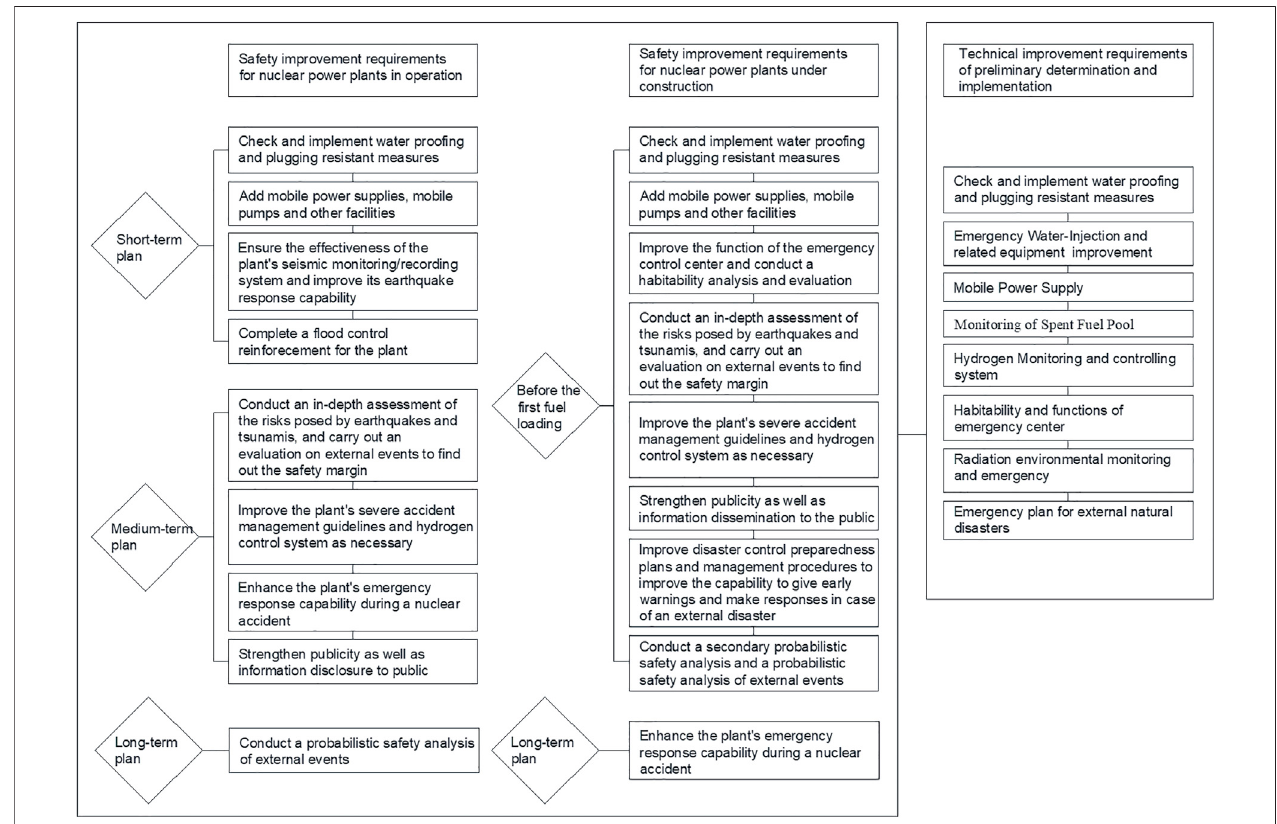
FIGURE 1 | Improvement actions and technical measures for China